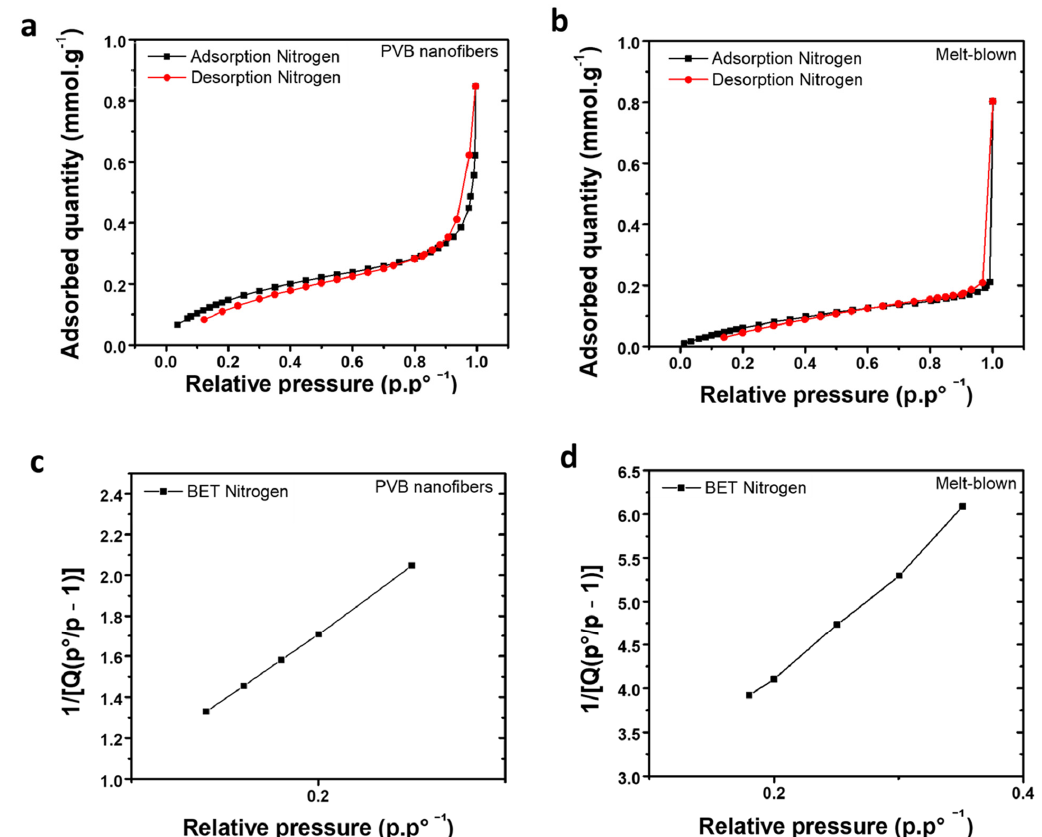
Figure 5. Langmuir adsorption isotherm and BET are plotted for PVB fibers and melt-blown fabric. The ( a ) and ( b ) plot describe PVB and melt-blown fabric Langmuir adsorption isotherm respectively whereas ( c ) and ( d ) describe PVB and melt-blown fabric BET respectively.